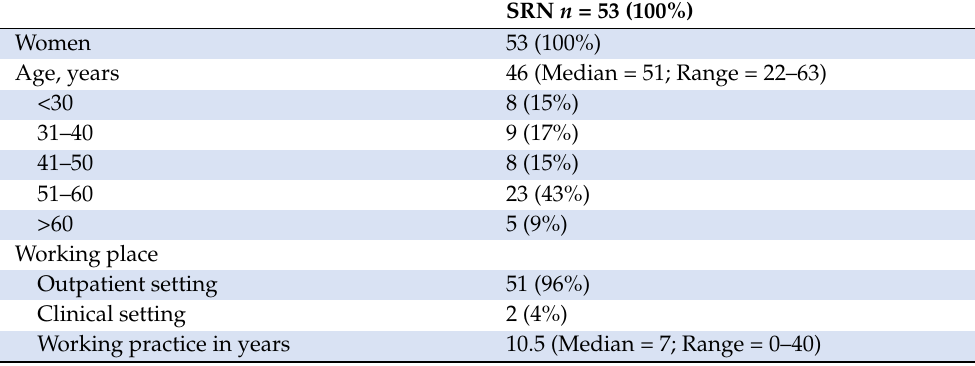
Table 2. Characteristics of SRN (mean or n